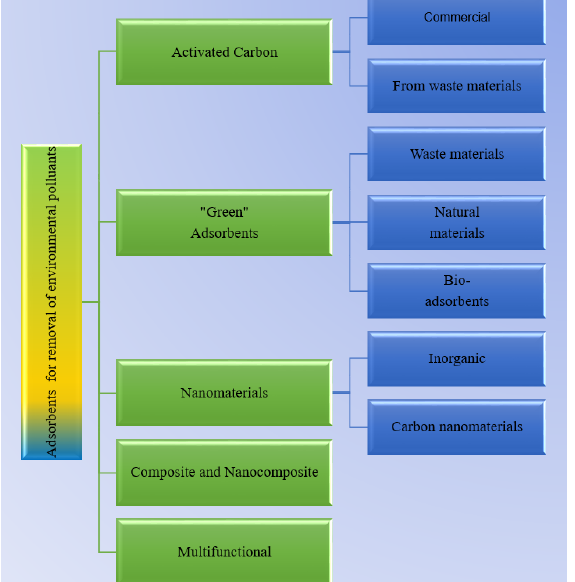
Figure 1. Carbon-based materials applied in environmental treatment of natural mineral waters.